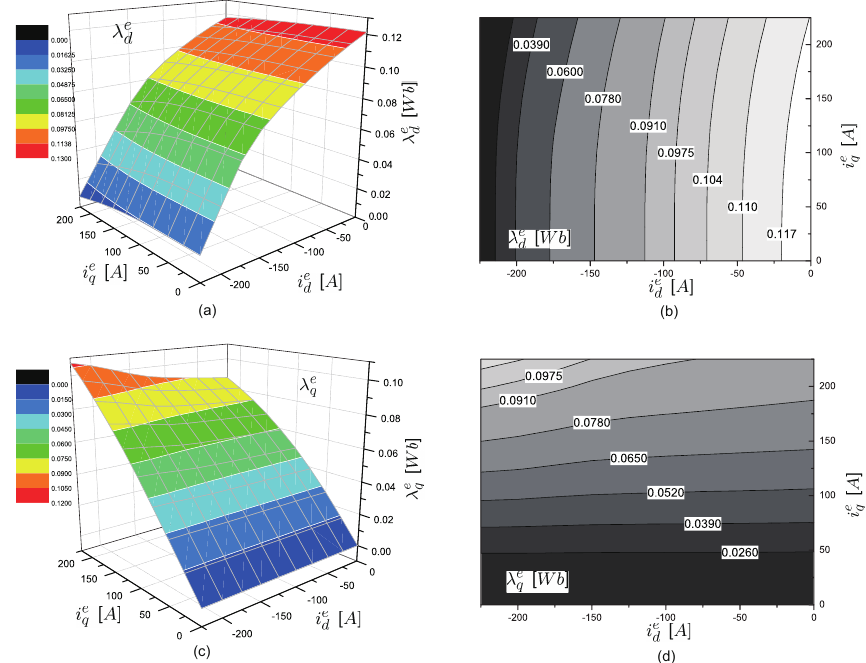
Figure 4. Flux linkages when i f = 6 A (FEM analysis): ( a ) 3-dimensional plot of λ e λ e ; ( c ) 3-dimensional plot of λ e q ; and ( d ) contour plot of λ e q . d